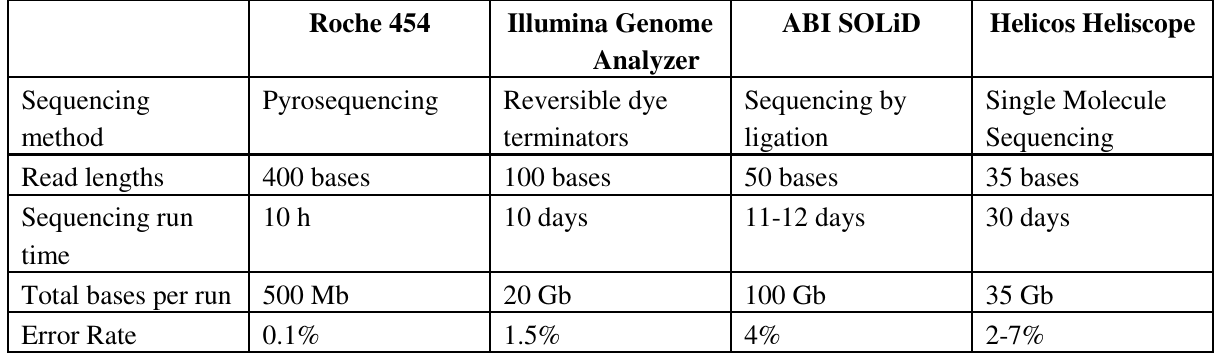
Table 1. Summary of the main features of the four HTS